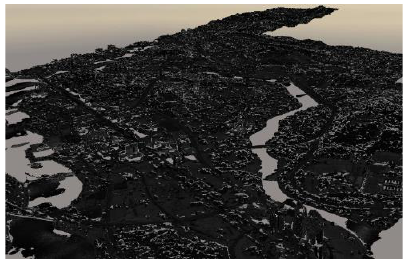
Figure 3: 3D Mesh Model for